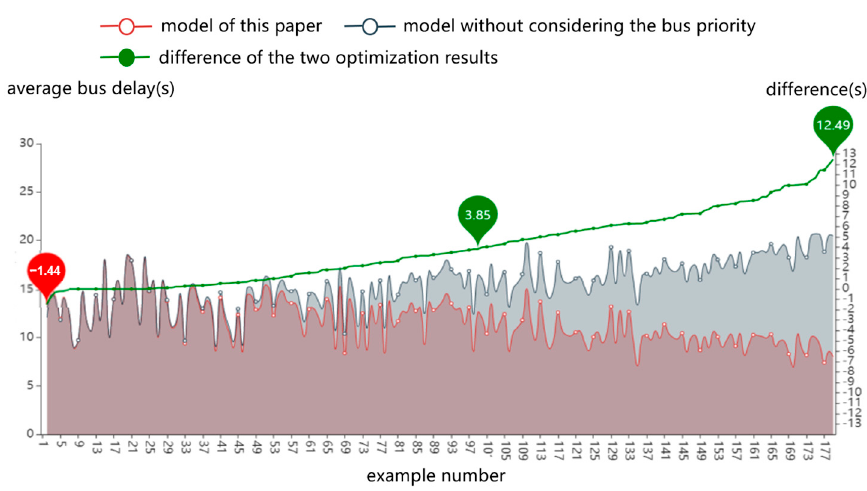
Figure 13. Comparison of the average bus delay after the optimization of the two models.